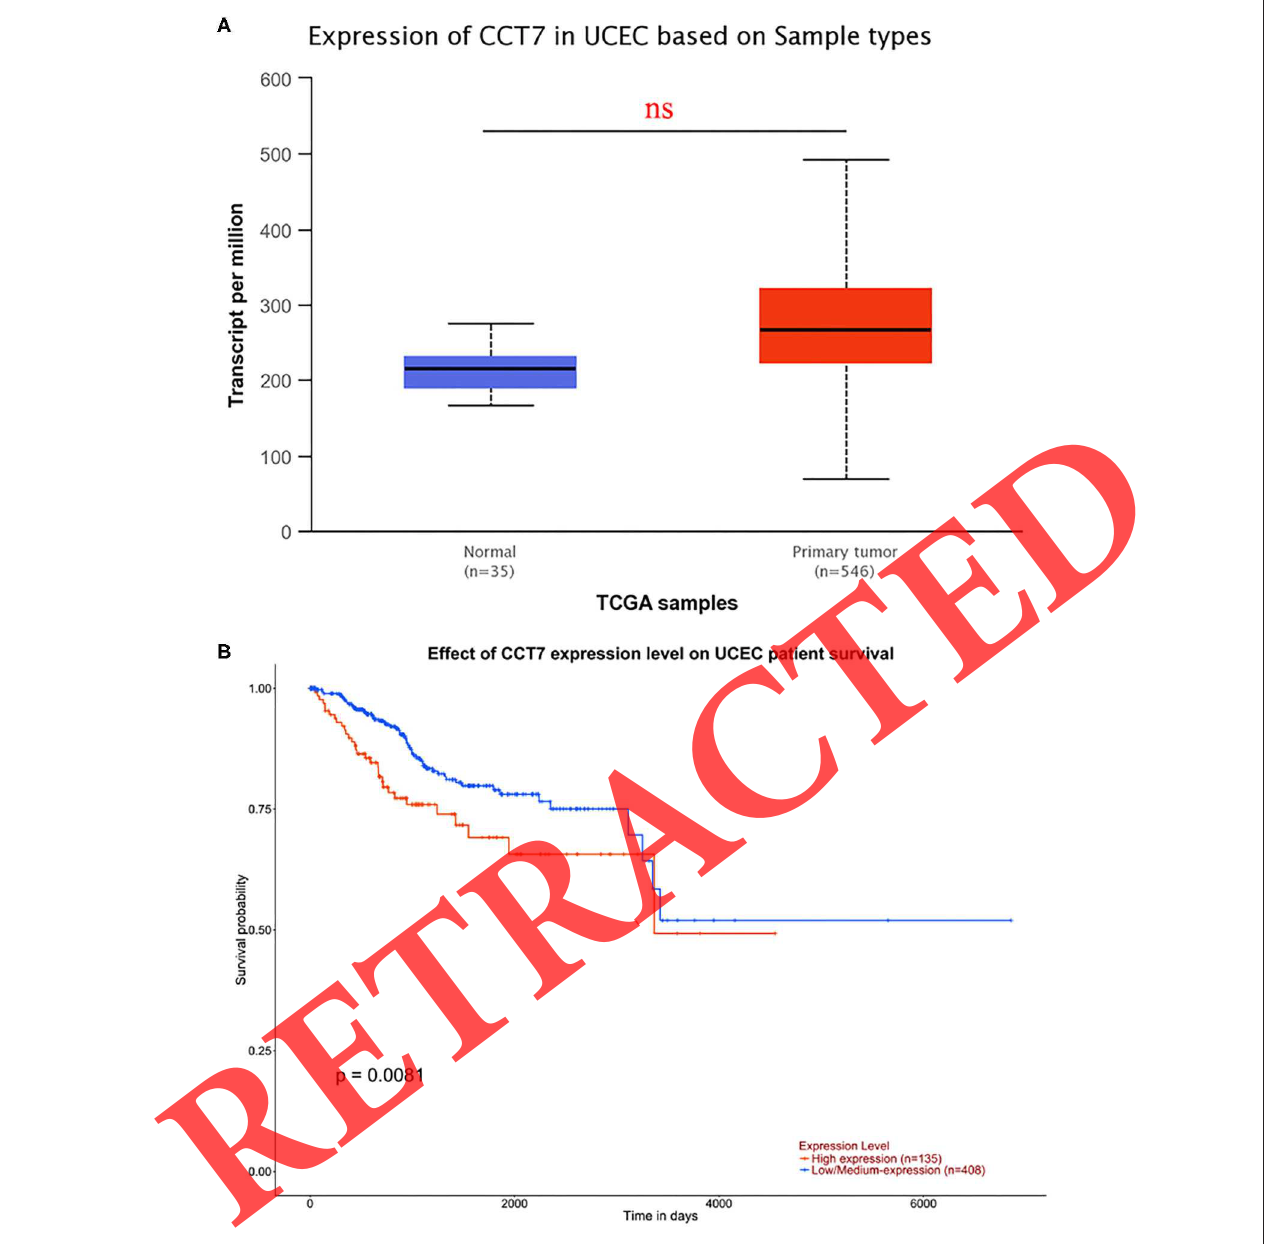
FIGURE 5 | Data Analysis from TCGA. CCT7 expression in normal samples ( n = 35) and UCEC ( n = 546) were analyzed based on TCGA (A) . Survival analysis was performed to test the effect of CCT7 expression level on UCEC patient survival (B) . UCEC, Uterine Corpus Endometrial Carcinoma.